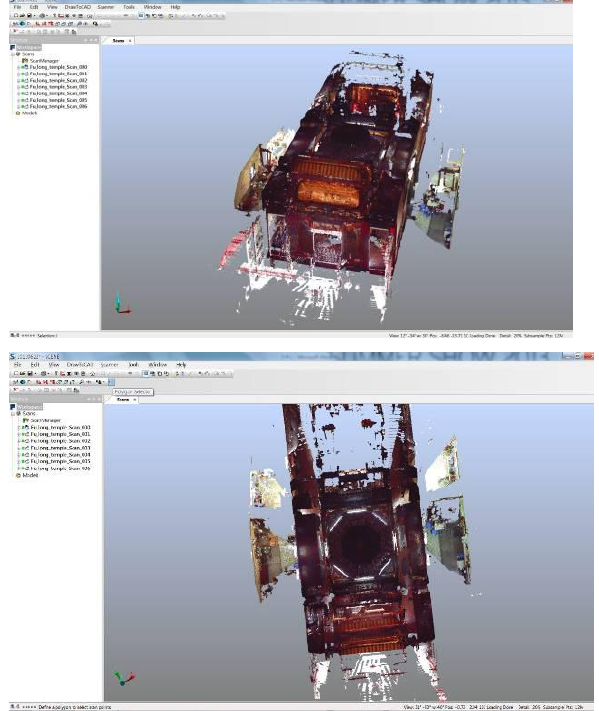
Figure 9. 3D laser scanning results